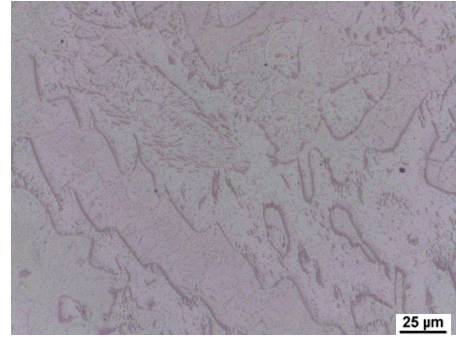
Figure 5. Casting structure of heat A.